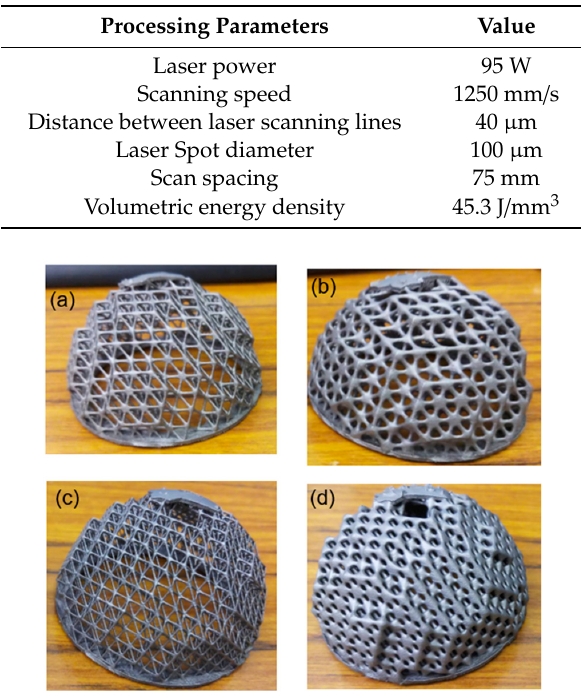
Table 4. Process parameter of SLM used to obtain the cellular implant.